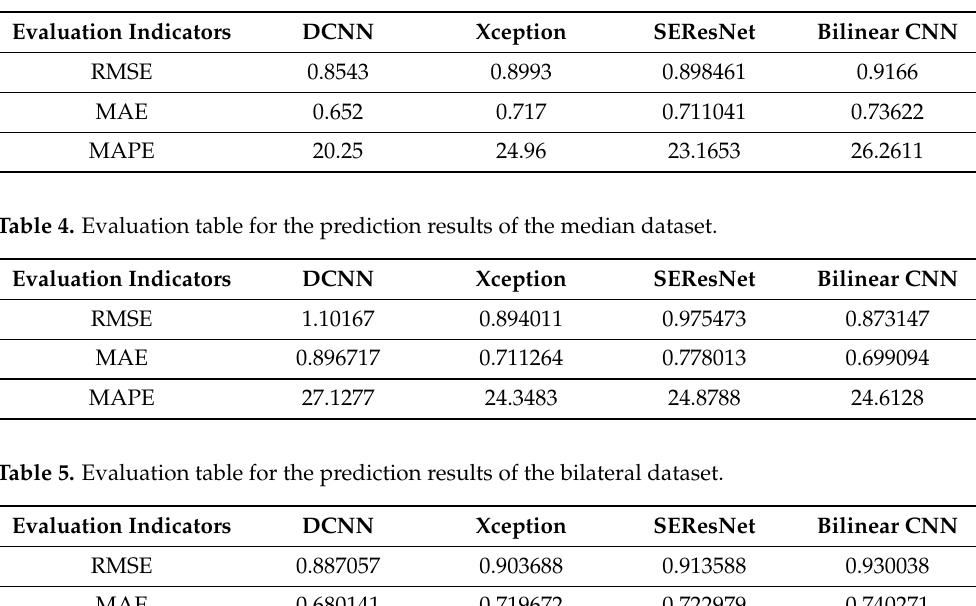
Table 3. Evaluation table for the prediction results of the Gaussian dataset.